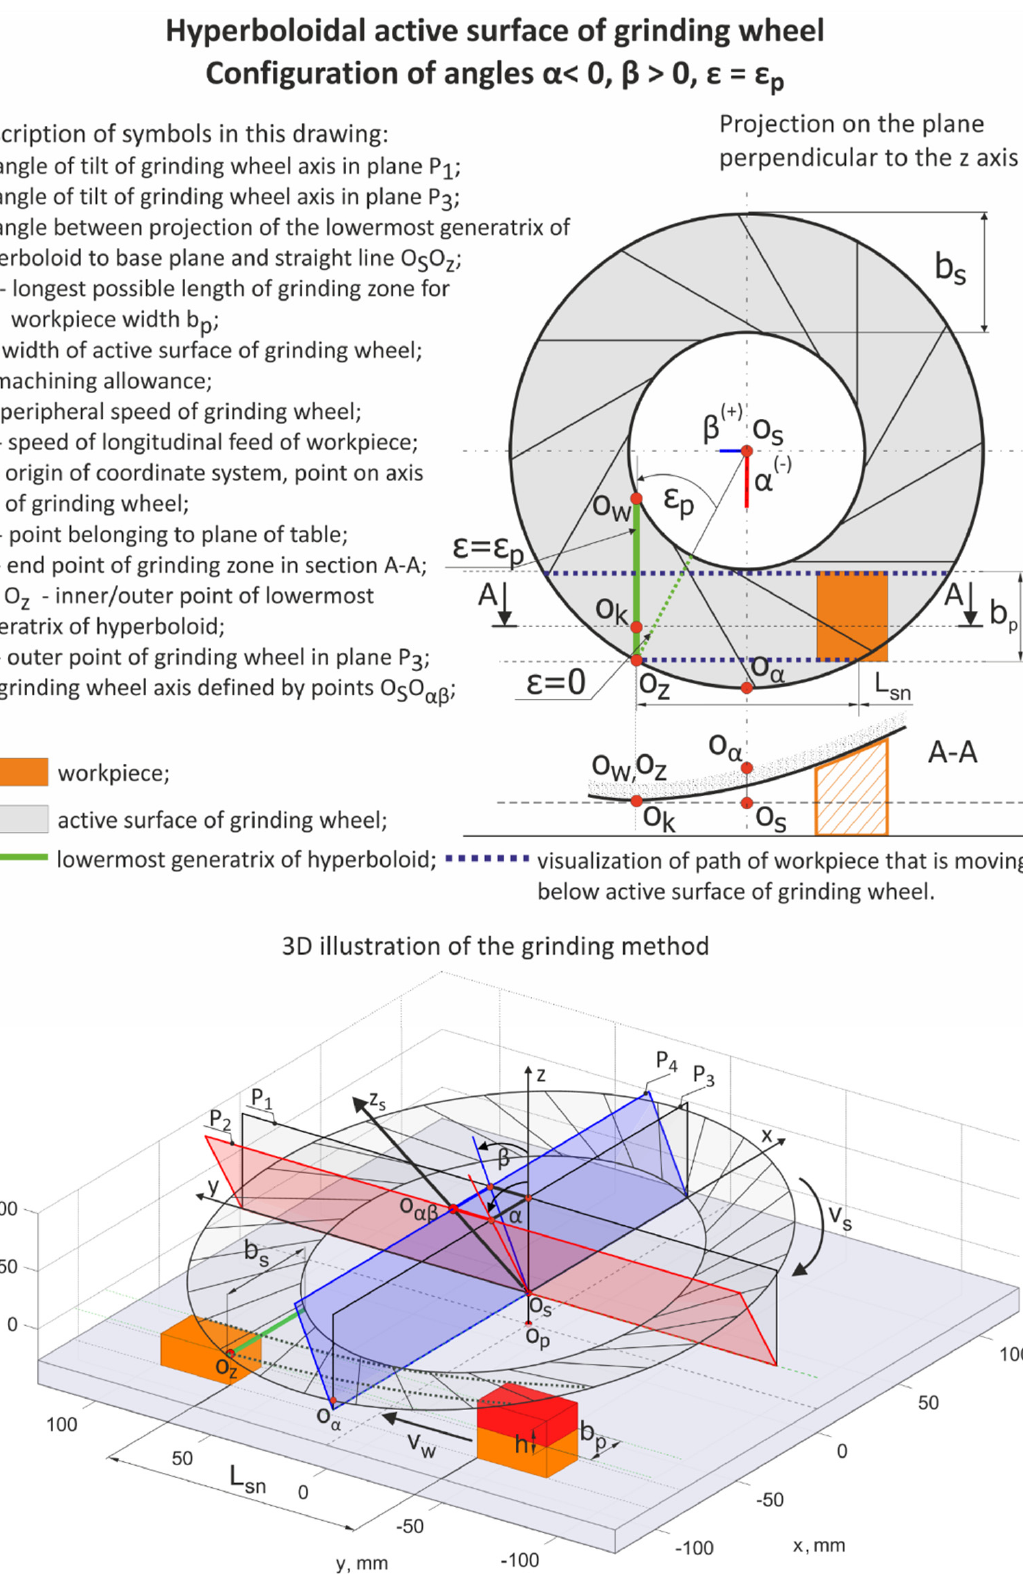
Figure 5. Schematic for the analysis of geometric and kinematic features of the innovative method for micro-grinding surfaces with the face of the grinding wheel.